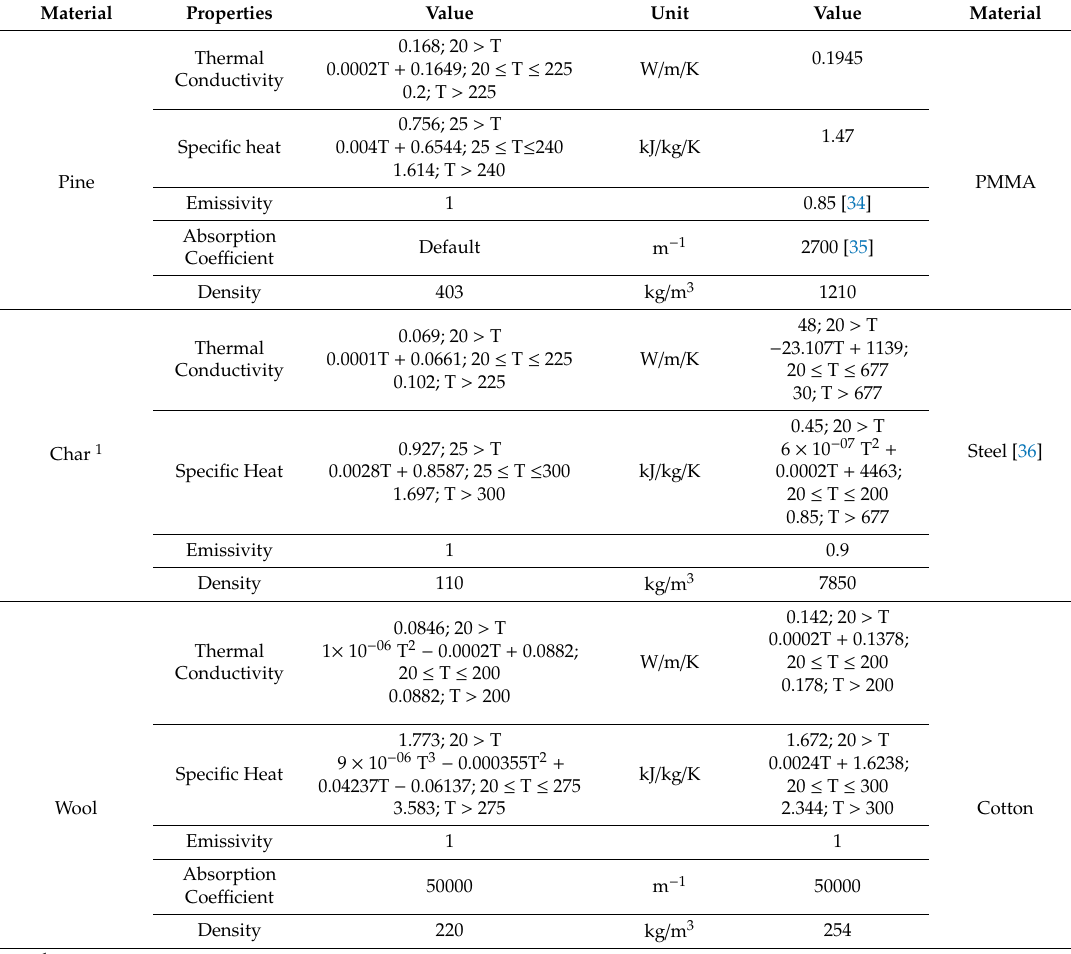
Table 4. Specified Thermo-Physical